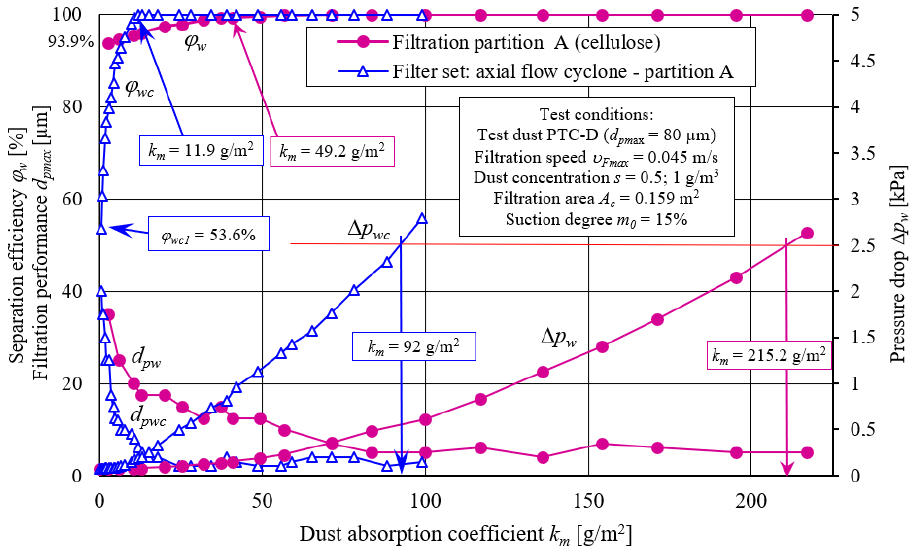
Figure 9. Characteristics: separation efficiency φ w = f ( k m ), pressure drop Δ p w = f ( k m ), and filtration performance d pmax = f ( k m ) as a function of dust absorption coefficient ( k m ) of filter material A working in the “filter set” as second filtration stage (downstream of the axial flow cyclone) and in a single- stage system.